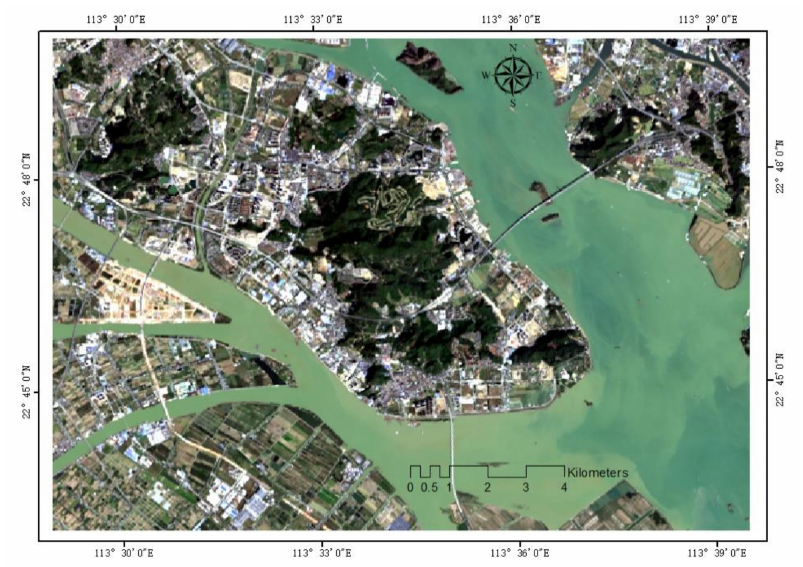
Figure 8. Landsat 8 image of the demonstration area.